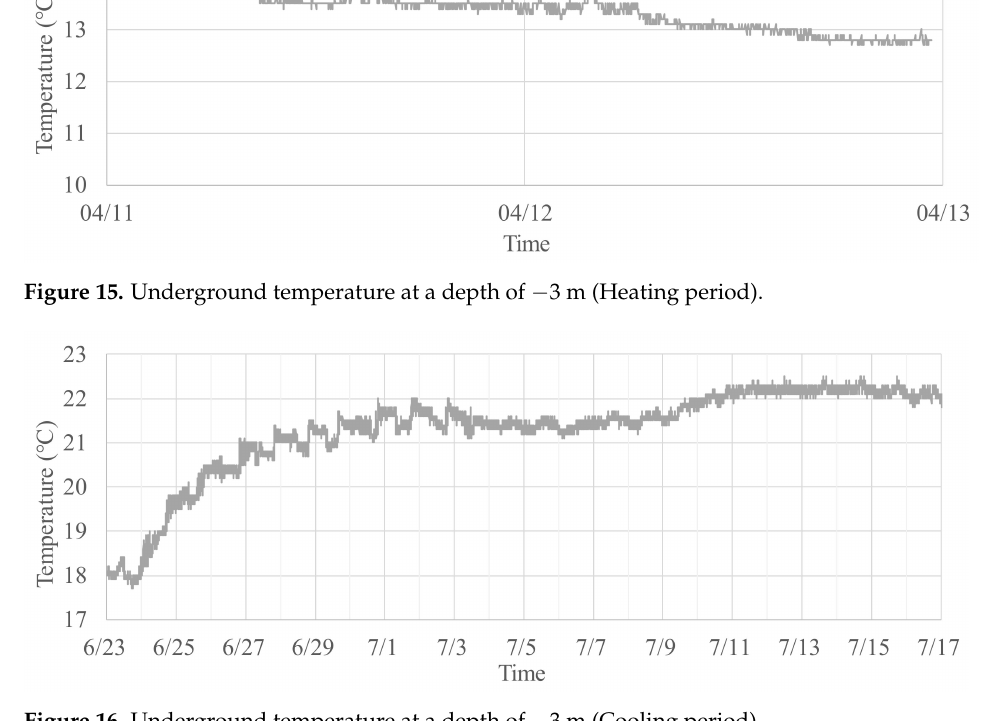
Figure 16. Underground temperature at a depth of − 3 m (Cooling